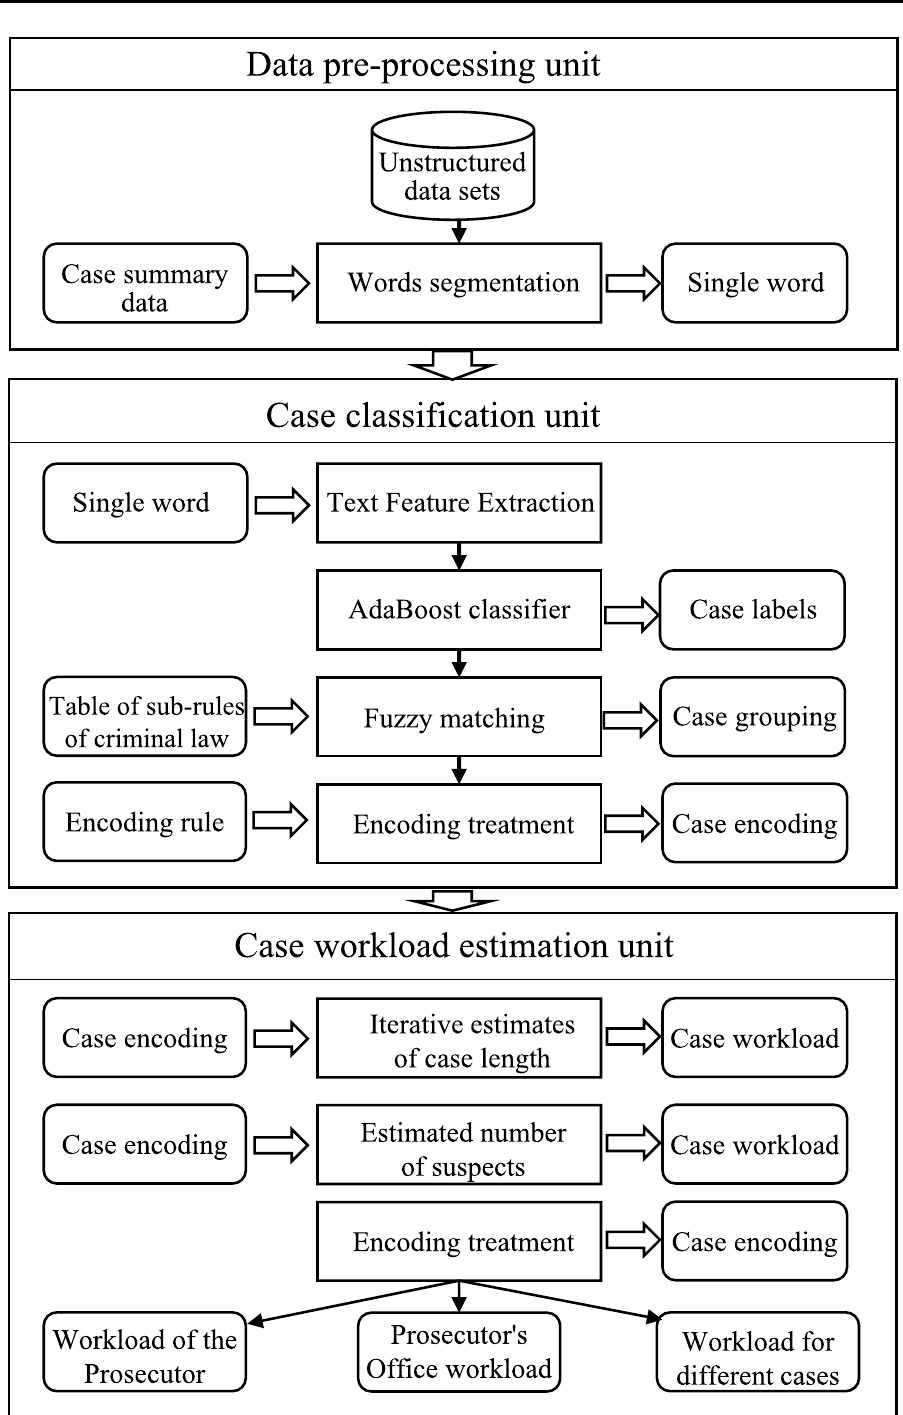
Fig. 1 Flow chart for estimating case